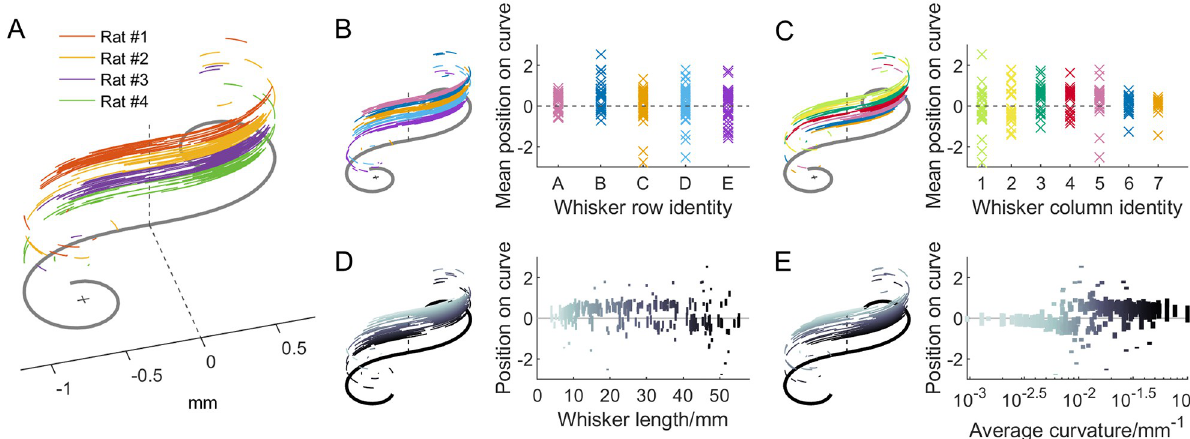
Fig 7. Whiskers are conformed onto the universal Euler spiral. (A) The heavy gray line indicates a universal Euler spiral. A total of 225 whiskers from four rats are conformed onto this spiral and vertically offset so that they can be visualized clearly. Color indicates whiskers from four different rats. (B) Left : Whiskers are mapped onto the Euler spiral and sorted (vertically offset) by their row identity. The conformed whiskers overlap almost completely (distinguishable only by the offset), indicating that the mapping shows no correlation to whisker row identity. Right : The mean position of the whisker on the Euler spiral is plotted as a function of row. (C) Identical to B, but for column identity instead of row identity. Again, the mapping shows no correlation to whisker column identity. (D) Left : Whiskers are sorted (vertically offset) by their arclength and mapped onto the Euler spiral. The grayscale matches the color of the arc length indicated in the right panel. Right : Each vertical line shows the span of the whisker conformed on the universal Euler spiral. No correlation is observed between arc length and either the mean location or the span of the whisker on the Euler spiral. (E) Identical to (D), but for average whisker curvature instead of arc